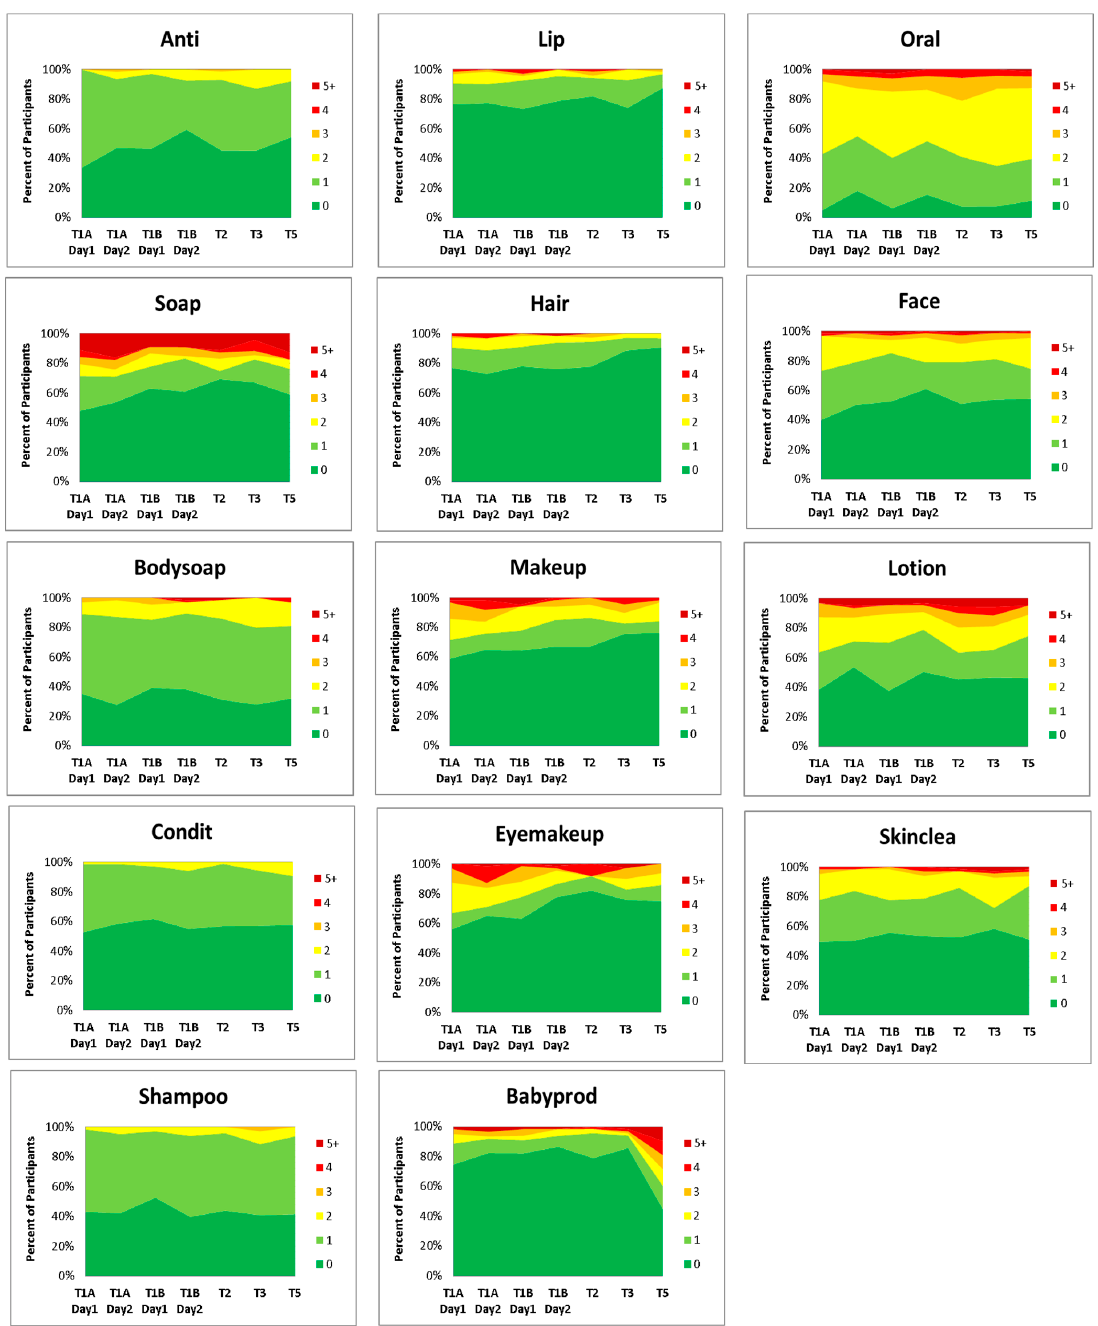
Figure 6. Frequency of Use. The percentage of participants who applied a PCP 0, 1, 2, 3, 4 and 5+ times in a 24 h period. The X-axis describes the time period.